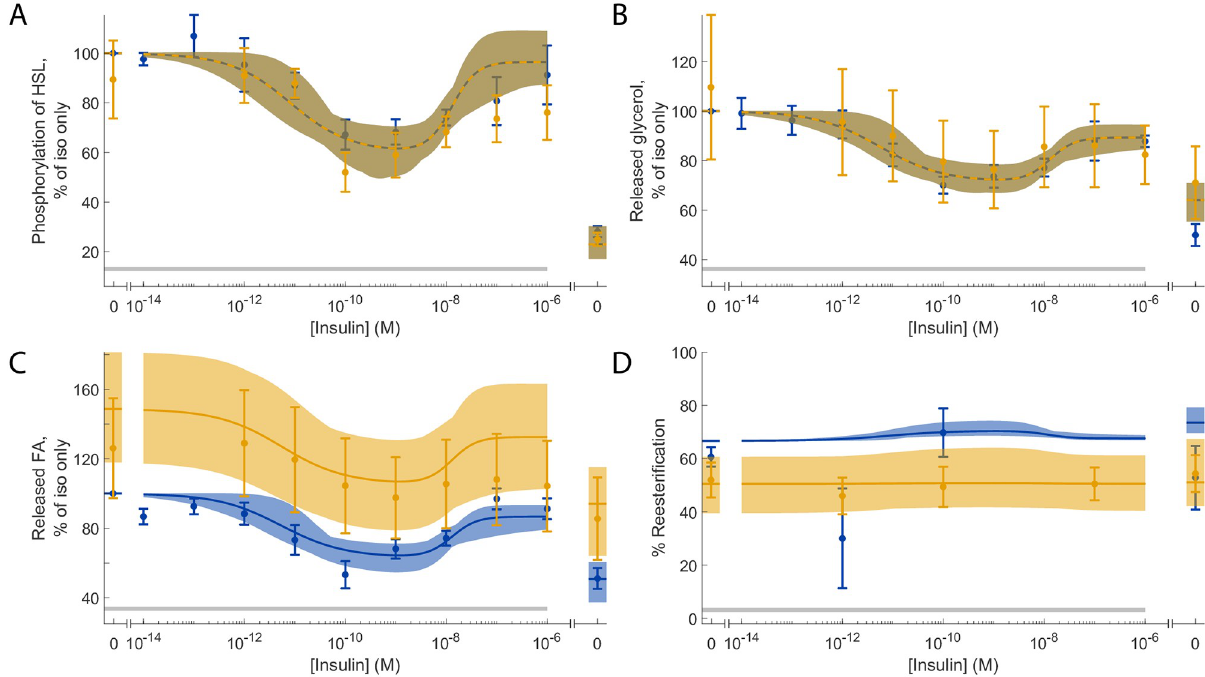
Fig 6. Model agreement when trained to the extended set of experimental data. In all panels, dots and error bars represent mean and SEM values, solid/dashed lines represent the model simulation with the best agreement to data, and the shaded areas represent the model uncertainty. (A), phosphorylation of HSL. (B), release of glycerol. (C), release of fatty acids (FA). (D), percentage of fatty acids being reesterified. Blue data/simulations correspond to normal conditions, and orange data/simulations correspond to type 2 diabetic conditions. The data for diabetic conditions in (A-C) and the data for normal conditions (D) were not used to train the model. In all panels, horizontal grey bars indicate where stimulation with isoproterenol (10 nM) was given. Furthermore, increasing concentrations of insulin were given together with 10nM isoproterenol in all points except one in all panels. The point without isoproterenol got no stimulus and is shown to the right in the graphs. The agreement with the rest of the original dataset ( in vitro experiments) is shown in S4 Fig.